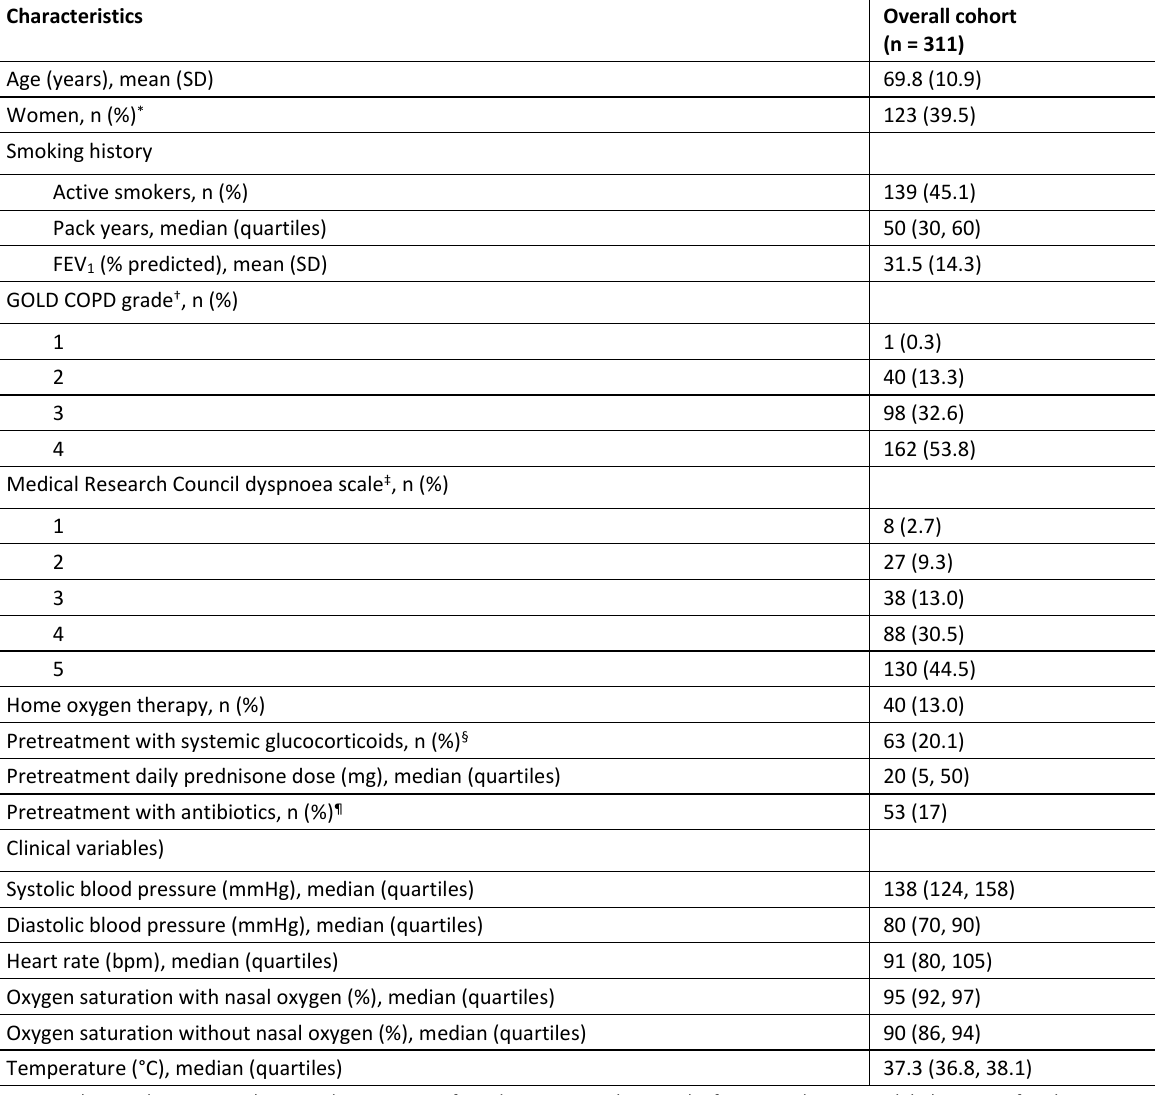
Table 1: Baseline characteristics of study participants. (Reproduced from ref. [29], with permission of the publisher.)